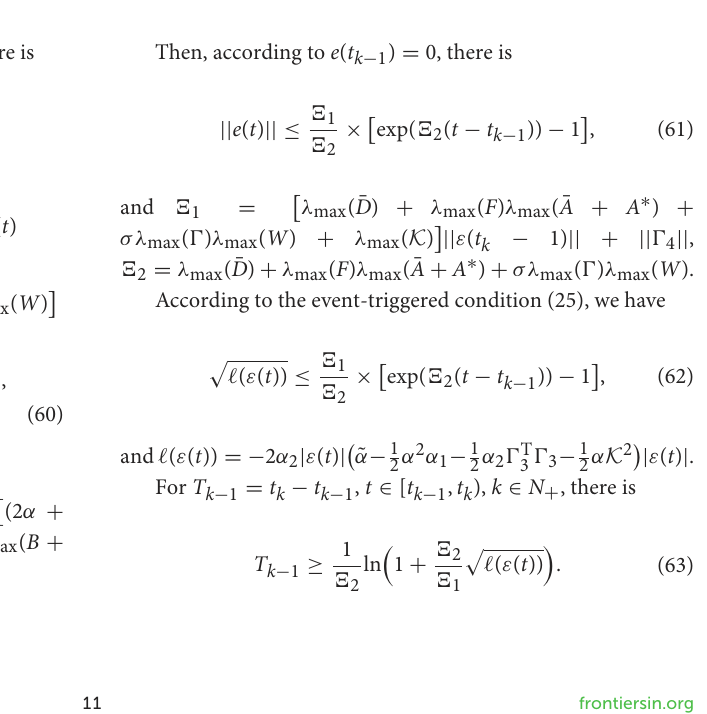
y ( t ) x ( t ) without control. (D) The synchronization errors ε ( t ) = −